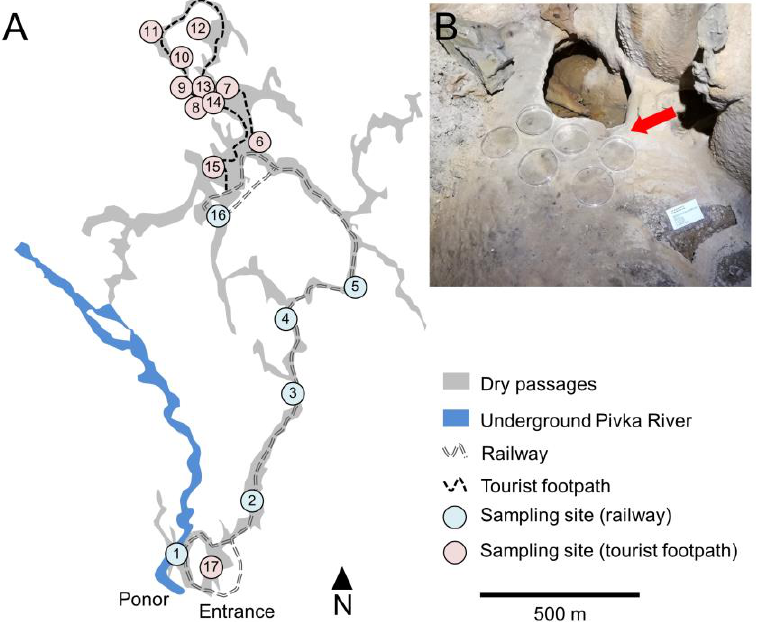
Figure 1. Setup of the experiment: ( A )—a map of Postojnska jama with designated locations for bioaerosol sampling along the underground railway (1–5, 16) and tourist footpath (2–15, 17) (ground plan modified from the Cave cadastre of the Karst Research Institute ZRC SAZU); ( B )—an example of open Petri plates for bioaerosol settling.